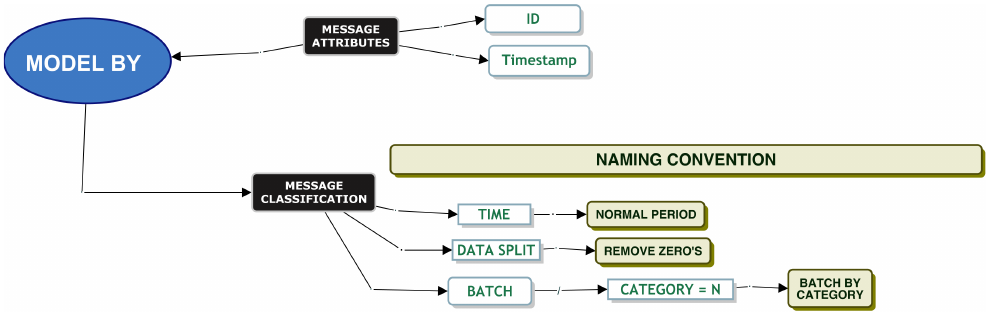
Figure 9. Batch by category, classification model. Table 10. Batch by category AD result.